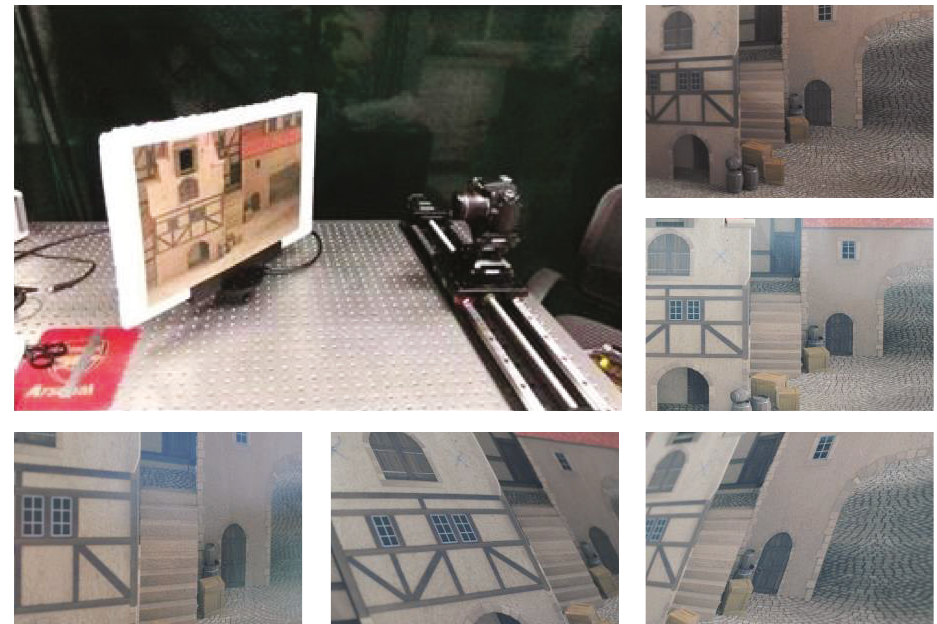
Figure 7: The left top one is our experimental environment. Others are printed light fields. Note that the scene in the left top is just one of the different situations, and our datasets contain 5 different tilt angles.